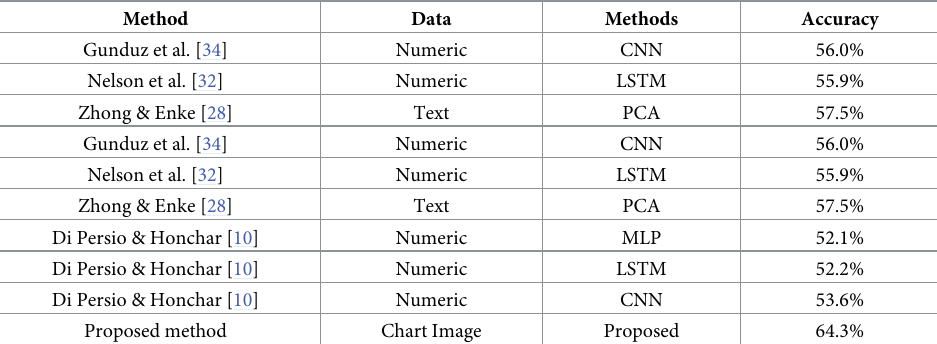
Table 8. Comparative performance between previous and present